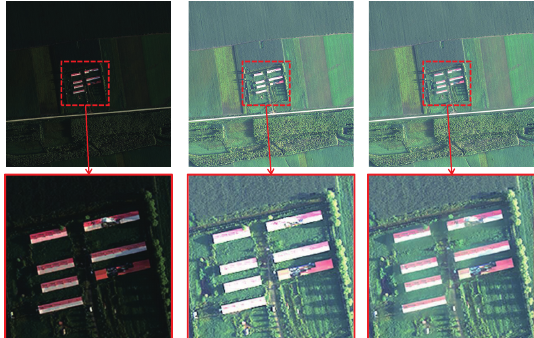
Figure 6. An illustration of our proposed structure transferring algorithm: (Left) the original image suffering from underexpo- sure; (Middle) the adjusted result by exposure compensation via Photoshop ; (Right) the structure-transferring image, which not only presents the similar appearance with the adjusted image but also preserves the local structures of the original image.